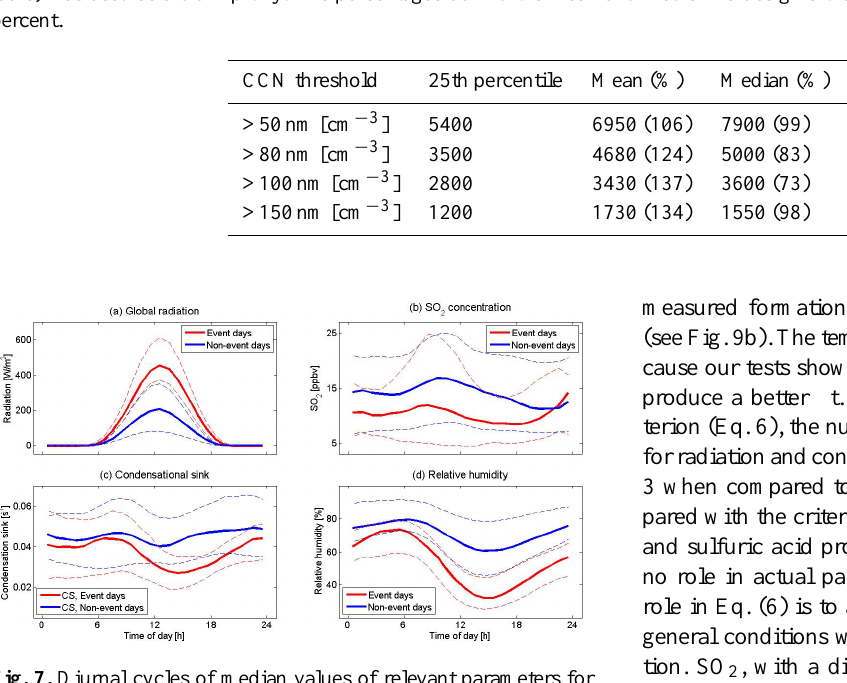
Fig. 7. Diurnal cycles of median values of relevant parameters for days with and without new particle formation. The dashed lines rep- resent the respective quartiles. (a) Global radiation. (b) SO 2 concen- tration. (c) Condensational sink. (d) Relative humidity.